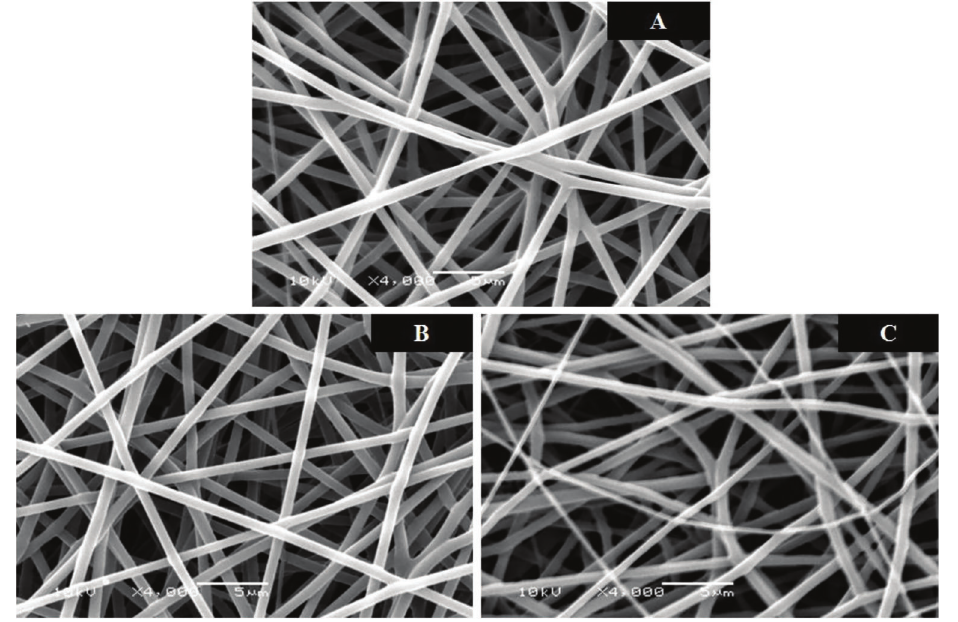
Figure 2. Microphotograph of the morphology of the scaffolds using scanning electron microscope (4,000 (cid:1) magni fi cation). A , PLGA/ BSA/VEGF matrix; B , PLGA/BSA scaffold; C , PLGA 13% matrix. PLGA: polylactic-co-glycolic acid; BSA: bovine serum albumin; VEGF: vascular endothelial growth